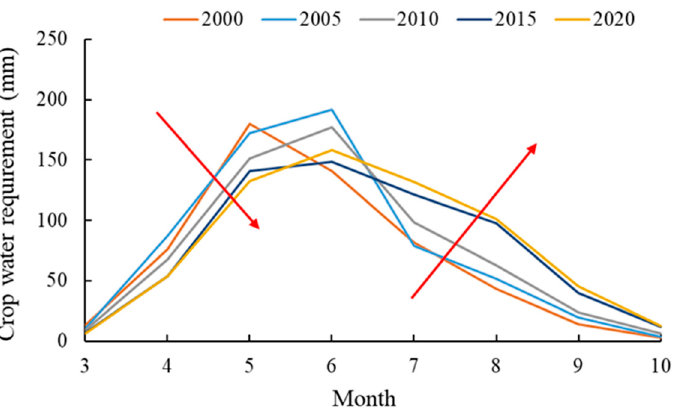
Figure 6. Monthly crop water demand for typical years. (Arrows indicate the changing trend of crop water demand from 2000 to 2020).